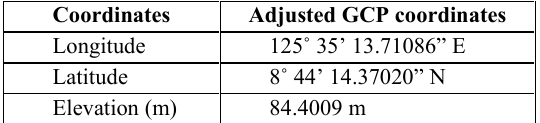
Table 3 . Ground Control Point Coordinates using GNSS